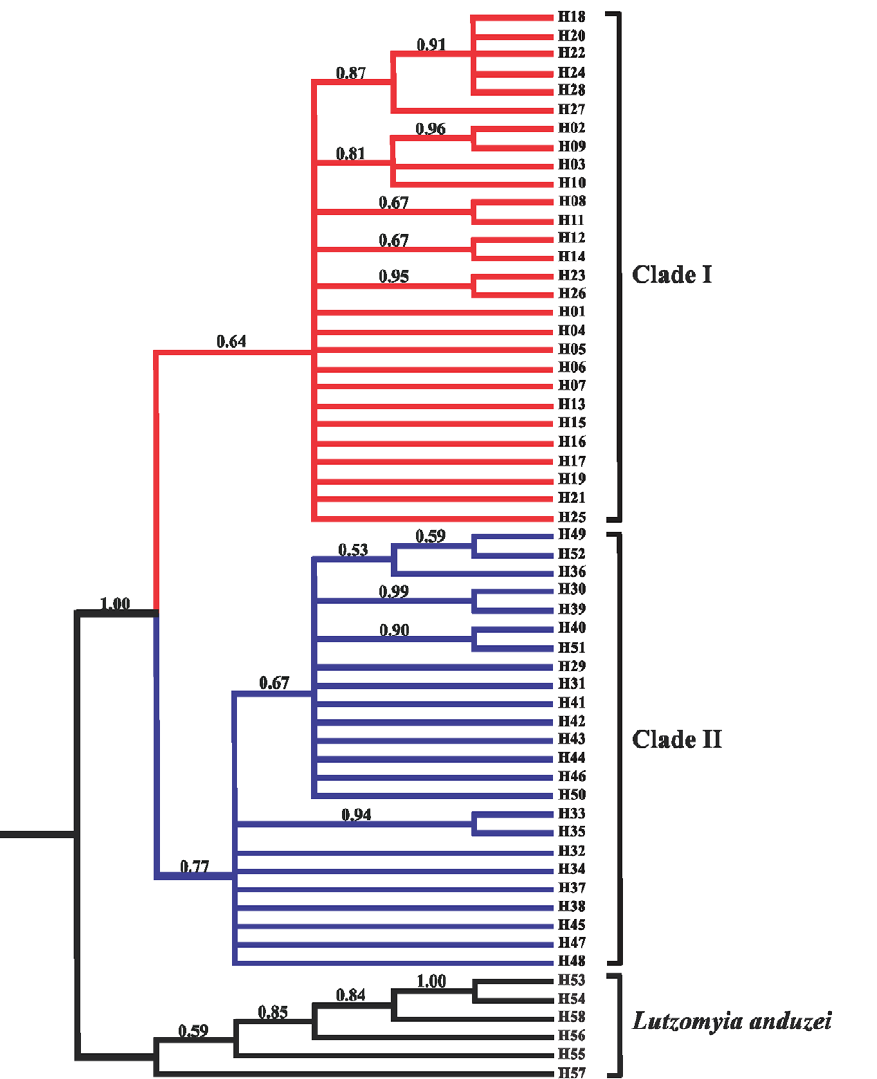
Figure 3. Bayesian Inference (BI) topology tree of the 52 haplotypes of Lutzomyiaumbratilis inferred under the TIM1 + I model. Numbers on each branch (above branch) represent posterior probabilities obtained in the BI. Lutzomyia anduzei was used as outgroup.